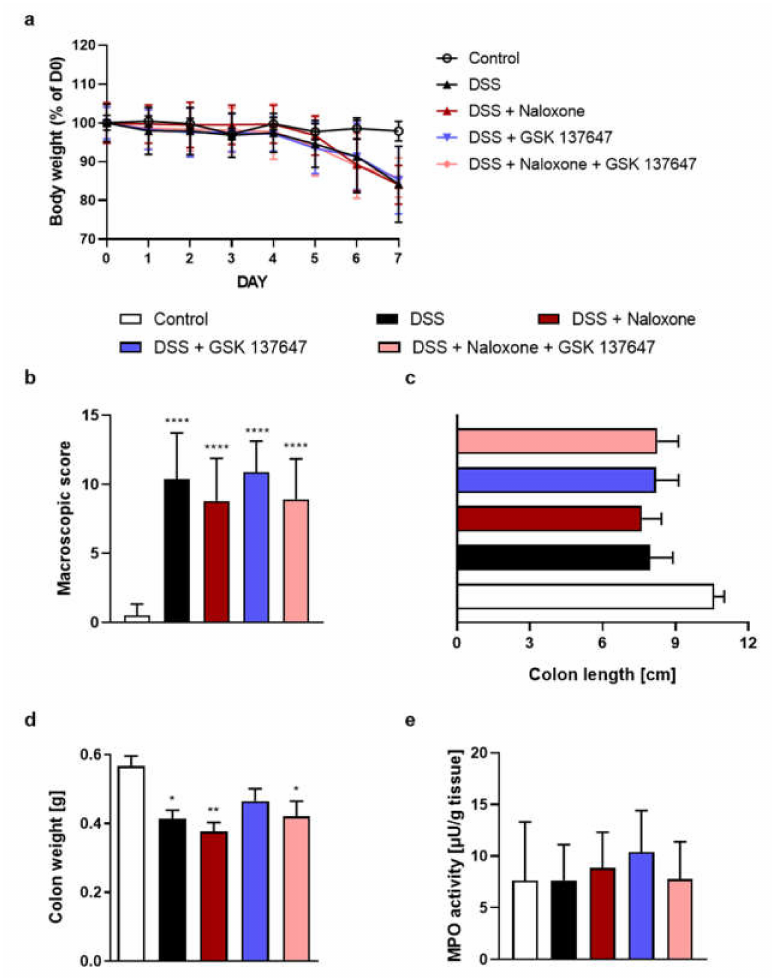
Figure 5. The i.p. administration of opioid receptor antagonist naloxone and FFAR4 agonist GSK 137647 (from day 3 to day 6, both 1 mg/kg BW, twice daily) did not alleviate symptoms of DSS- induced colitis in mice. Figure shows data for body weight loss ( a ), macroscopic score ( b ), colon length ( c ), colon weight ( d ) and MPO activity ( e ). * p < 0.05, ** p < 0.01 and **** p < 0.0001 as compared to control mice. Data represent mean ± SEM of 5–10 mice per group.